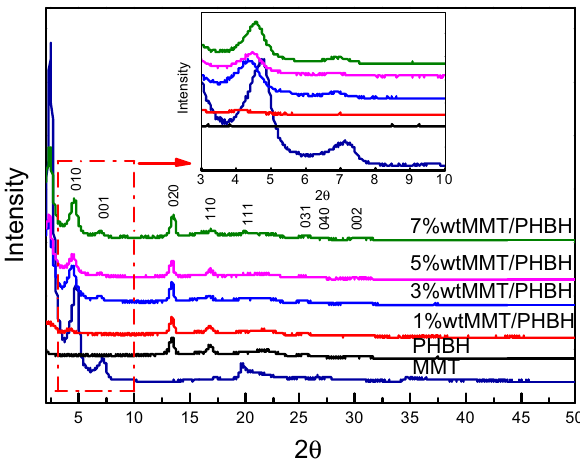
Figure 3: The X - ray di ff raction pattern of MMT, PHBH, and MMT/ PHBH